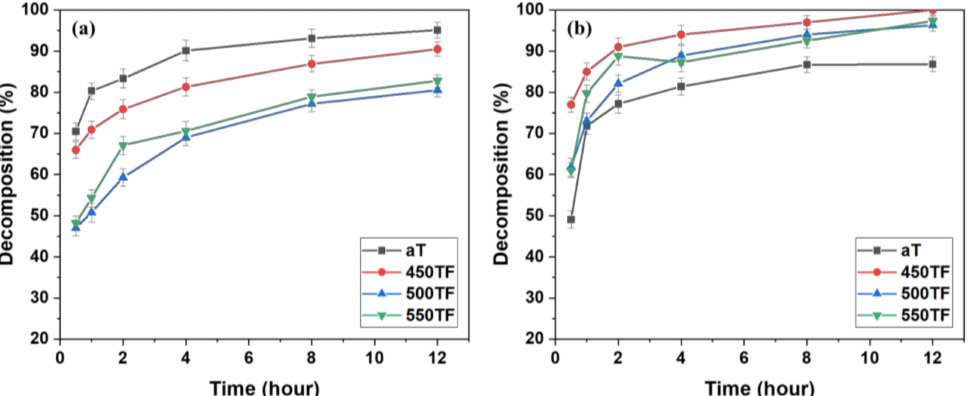
Figure 4. Photocatalytic self-cleaning properties of the photocatalyst-treated PET fabrics under ( a ) UV and ( b ) sunlight.